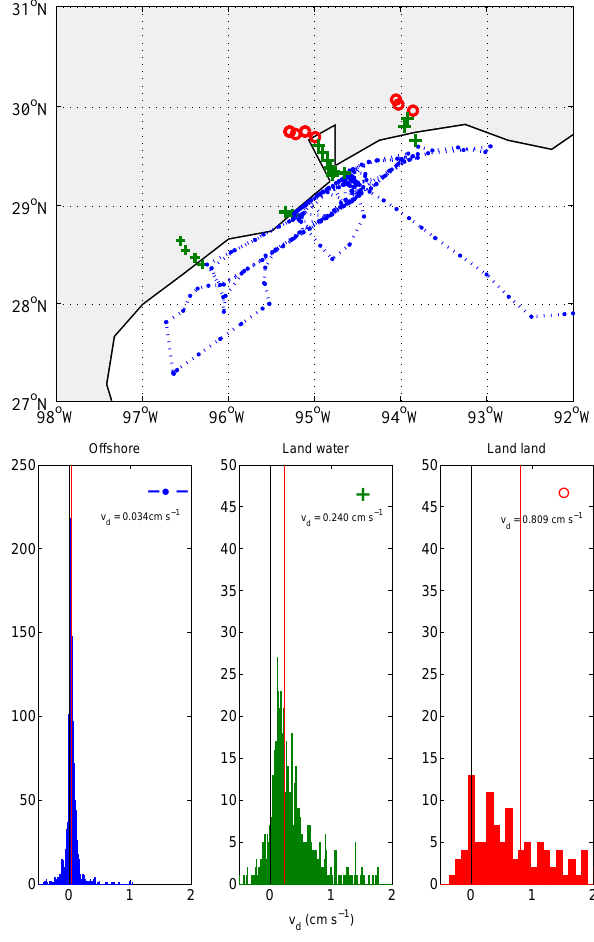
Fig. 13. The top panel shows the TexAQS-2006 cruise track bro- ken up into three sampling categories. Dots represent the offshore locations, the plus signs represent the bay areas, and the circles show inland data. The lower panel depicts ozone deposition ve- locity result (for 10-min measurement segments) histograms corre- sponding to the three different sampling regions defined in the upper panel. The offshore data show a median ozone deposition velocity of 0.034cms − 1 (indicated by vertical red line) for a total of 1953 number of points. The median ozone deposition velocity for the bay areas is 0.24cms − 1 (937 number of points), and for the inland data the median is 0.81cms − 1 (161 number of